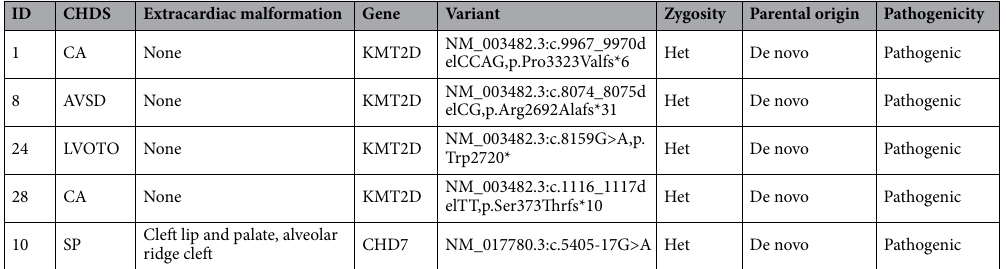
Table 4. Clinical phenotypes and identified pathogenic variants in cases with positive results. AVSD atrioventricular septal defect, CA conotruncal anomalies, CHDS congenital heart defect subtype, Het heterozygous, LVOTO left ventricular outflow tract obstruction, SD septal defects.